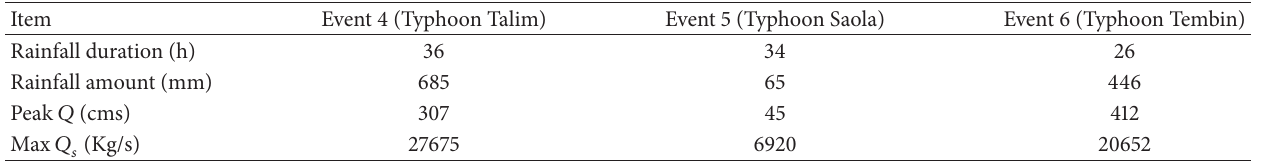
Table 1: Hydraulic characteristics of the six torrential